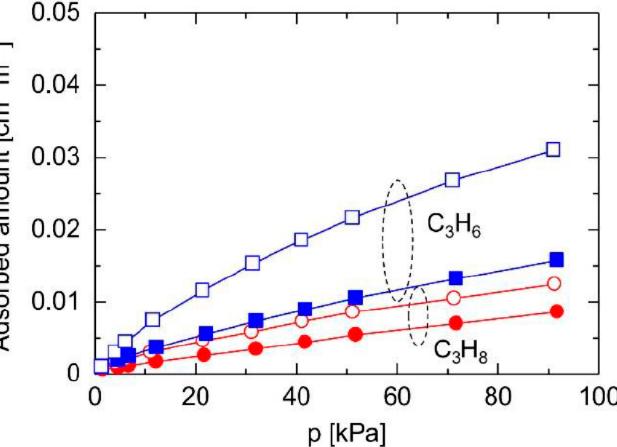
Figure 16. C 3 H 6 and C 3 H 8 adsorption isotherms at 25 °C for the triethoxyfluorosilane (TEFS) powders calcined at 350 °C before/after steam treatment (closed symbols: before steam treatment, open symbols: after steam treatment) [118]. Table 10. C 3 H 6 /C 3 H 8 separation performances of (organo)silica membranes.